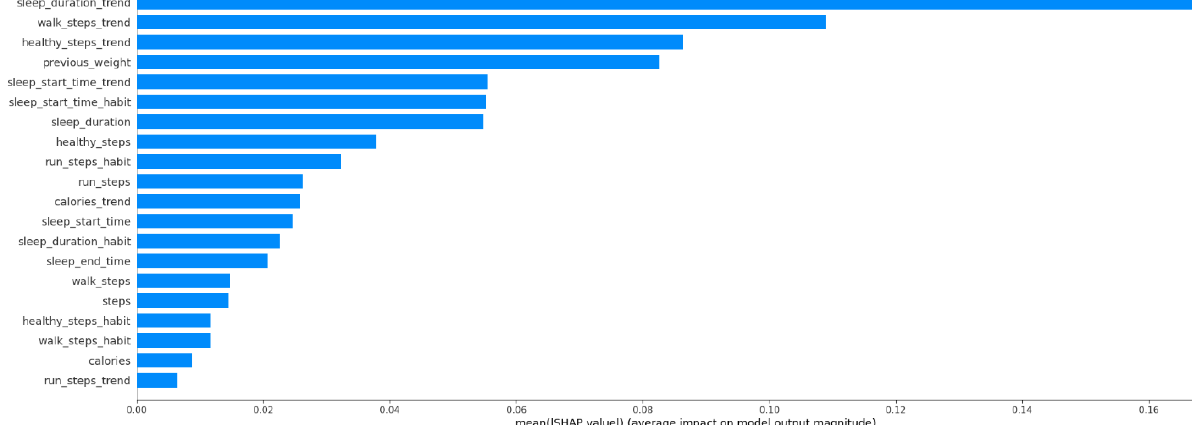
Figure 3. Average impact of feature vector elements on weight change predictions (20 most influential elements shown).